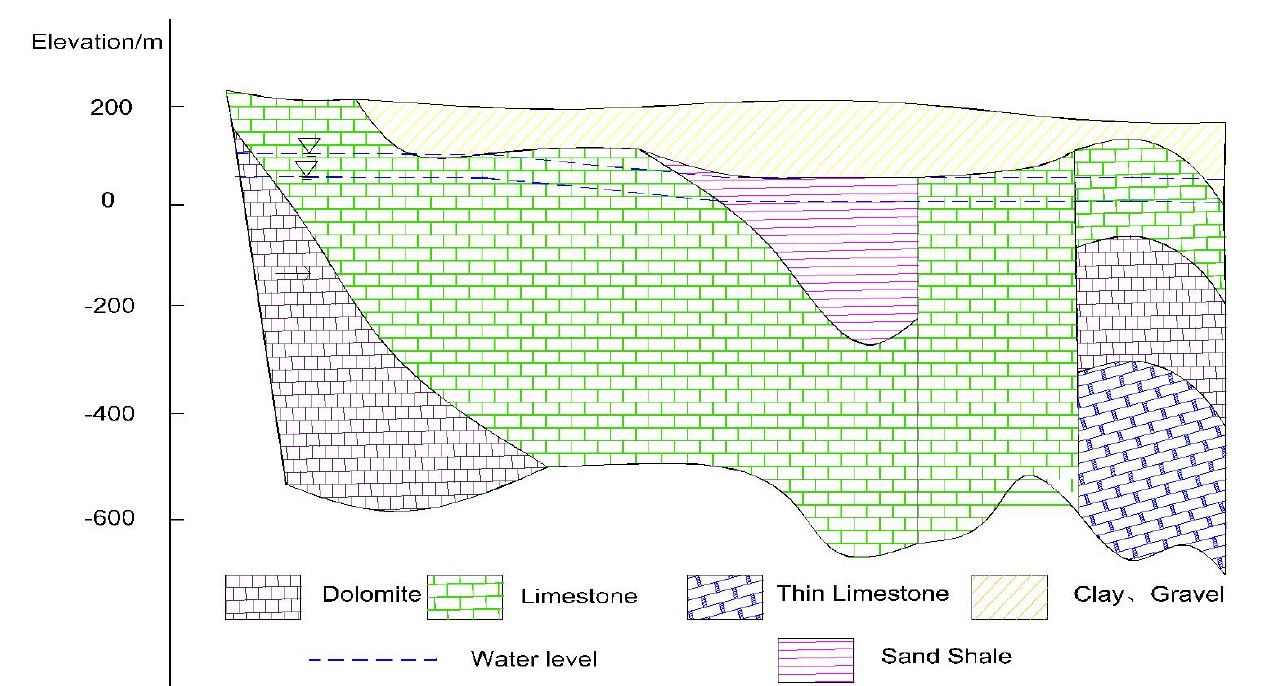
Figure 2. Geological profile of the Baiquan Underground Reservoir.